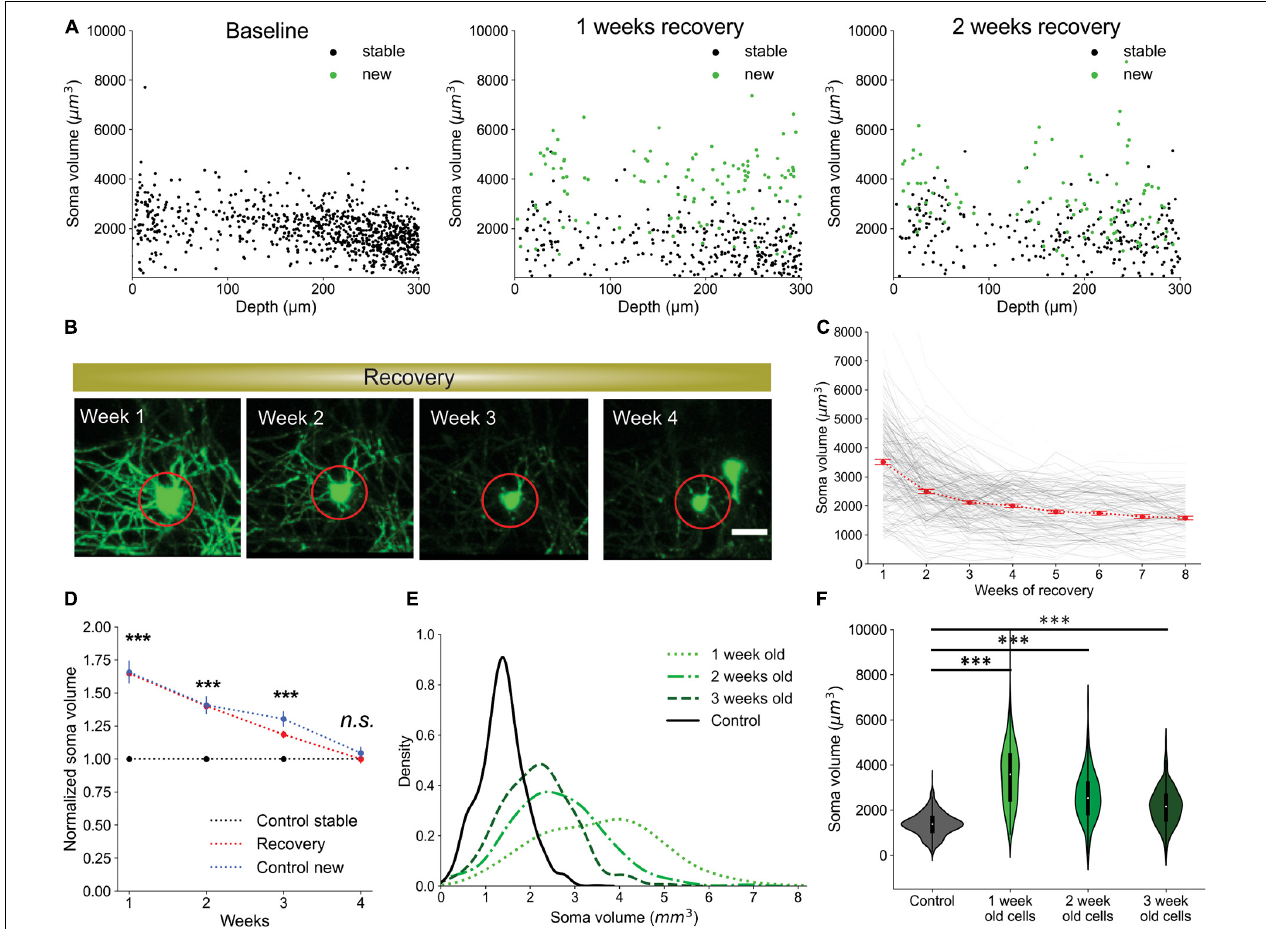
FIGURE 7 | Newly generated oligodendrocytes can be identified by cell soma volume. (A) Soma volume of stable and newly formed oligodendrocytes at baseline, 1 week recovery, and 2 weeks recovery across different cortical depths. (B) Representative example of the change in soma size of newly formed oligodendrocyte tracked across 4 weeks of recovery. Scale bar: 20 µ m. (C) Plot of decrease in soma volume for 250 cells over weeks relative to time of cell generation. Red dots are mean ± SEM. (D) Comparison of soma volume in newly formed oligodendrocytes during recovery compared with stable cells in non-treated mice. Also includes comparison of soma volume between spontaneously formed oligodendrocytes and stable cells in non-treated mice. All values are normalized to the mean soma volume of stable control cells at each matched timepoint. (E) Kernel density estimate for each distribution of soma volumes at indicated timepoints. These normalized distributions help visualize the probability that a cell with a certain soma volume is within a certain age range post-oligodendrogenesis. (F) Distribution of soma volumes of cells that are 1, 2, and 3 weeks old relative to cells in mice that are not treated with cuprizone at matched timepoints. Cells pooled from n = 4 cuprizone treated and n = 3 control mice. See Supplementary Table 1 for statistical tests and significance level for each comparison. *** p <